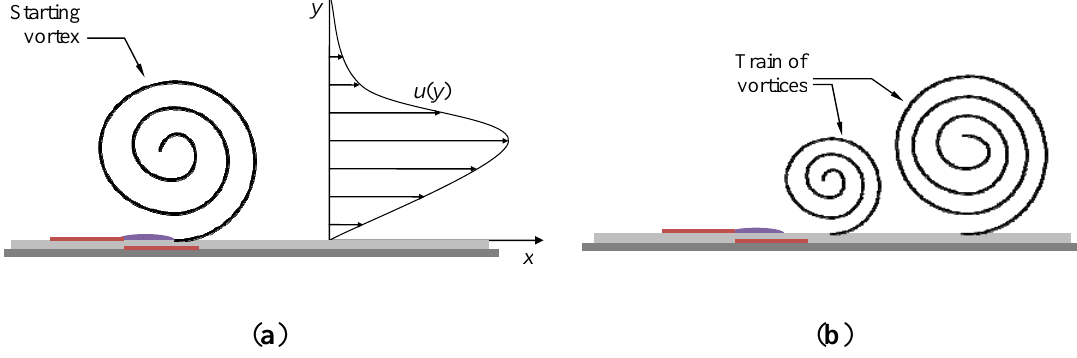
Figure 2. Flow induced by a single dielectric barrier discharge (DBD) plasma actuator operated in ( a ) continuous (steady) mode and ( b ) burst (unsteady)